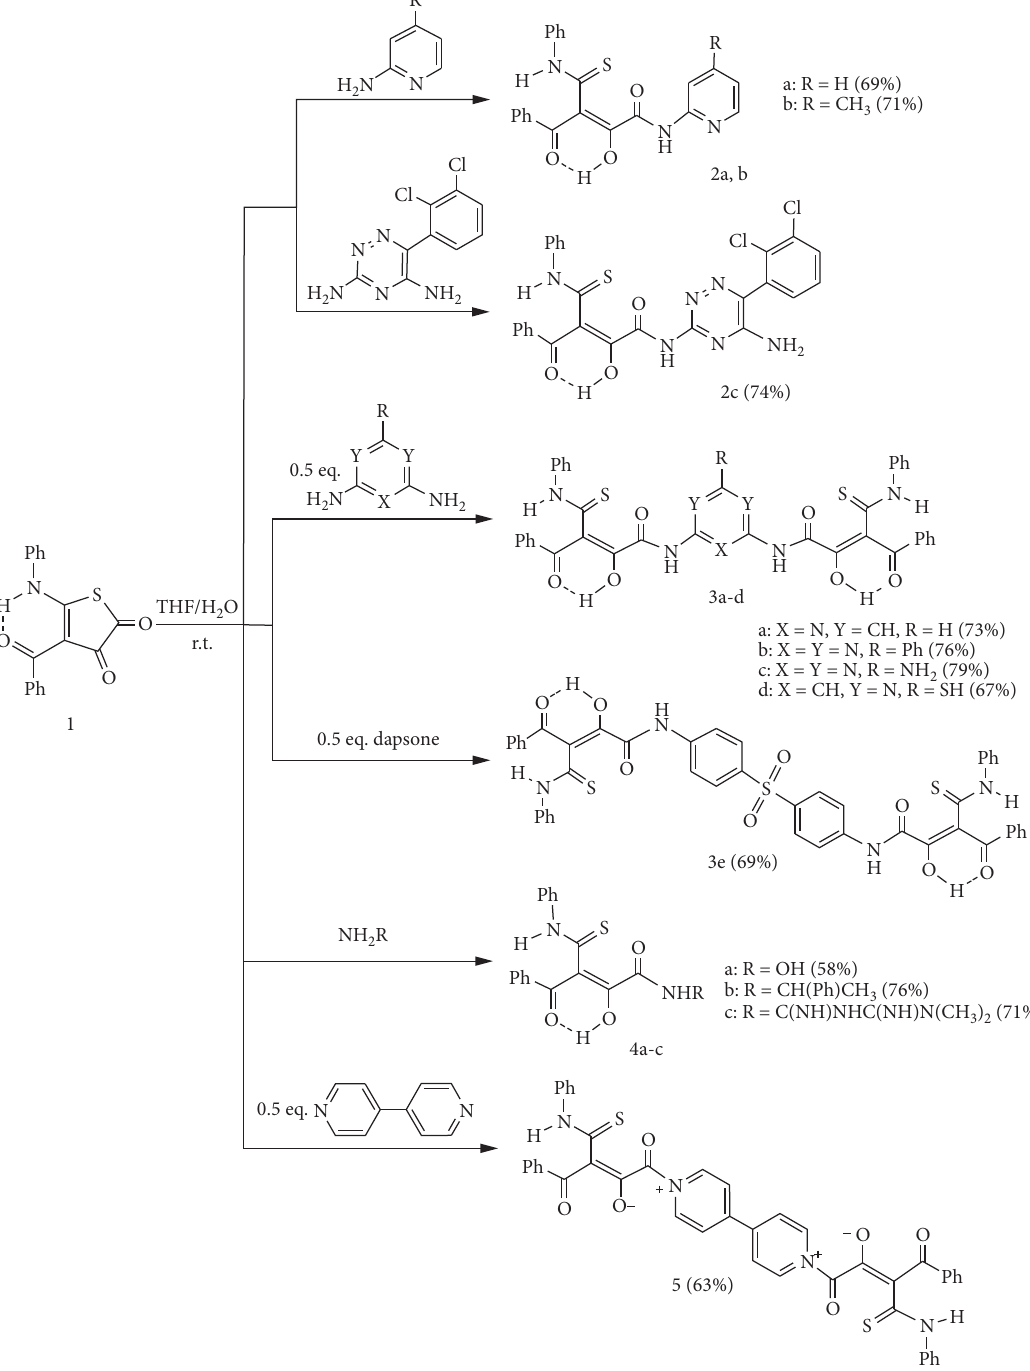
Scheme 2: Reactions of 1 with aminoheteroaromatics, dapsone, NH